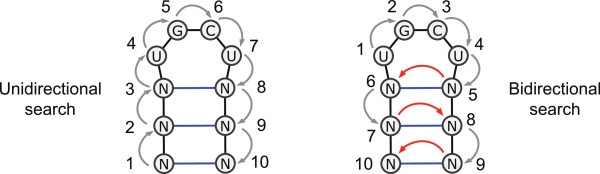
Unidirectional (left) and bidirectional (right) searches for the RNA sequence-structure pattern (RSSP)  with P = NNNUGCUNNN and R = (((....))), which represents a stem-loop structure of length m = 10. The numbers indicate the order in which the pattern characters are matched against the target sequence. In the unidirectional search, the characters are matched in a single direction, beginning (ending) with a character in φ(P[0]) (φ(P[m - 1])). In the bidirectional search, the loop region of the pattern can be matched first. Then, pairing bases are matched consecutively by switching the search direction, represented by the red arrows.